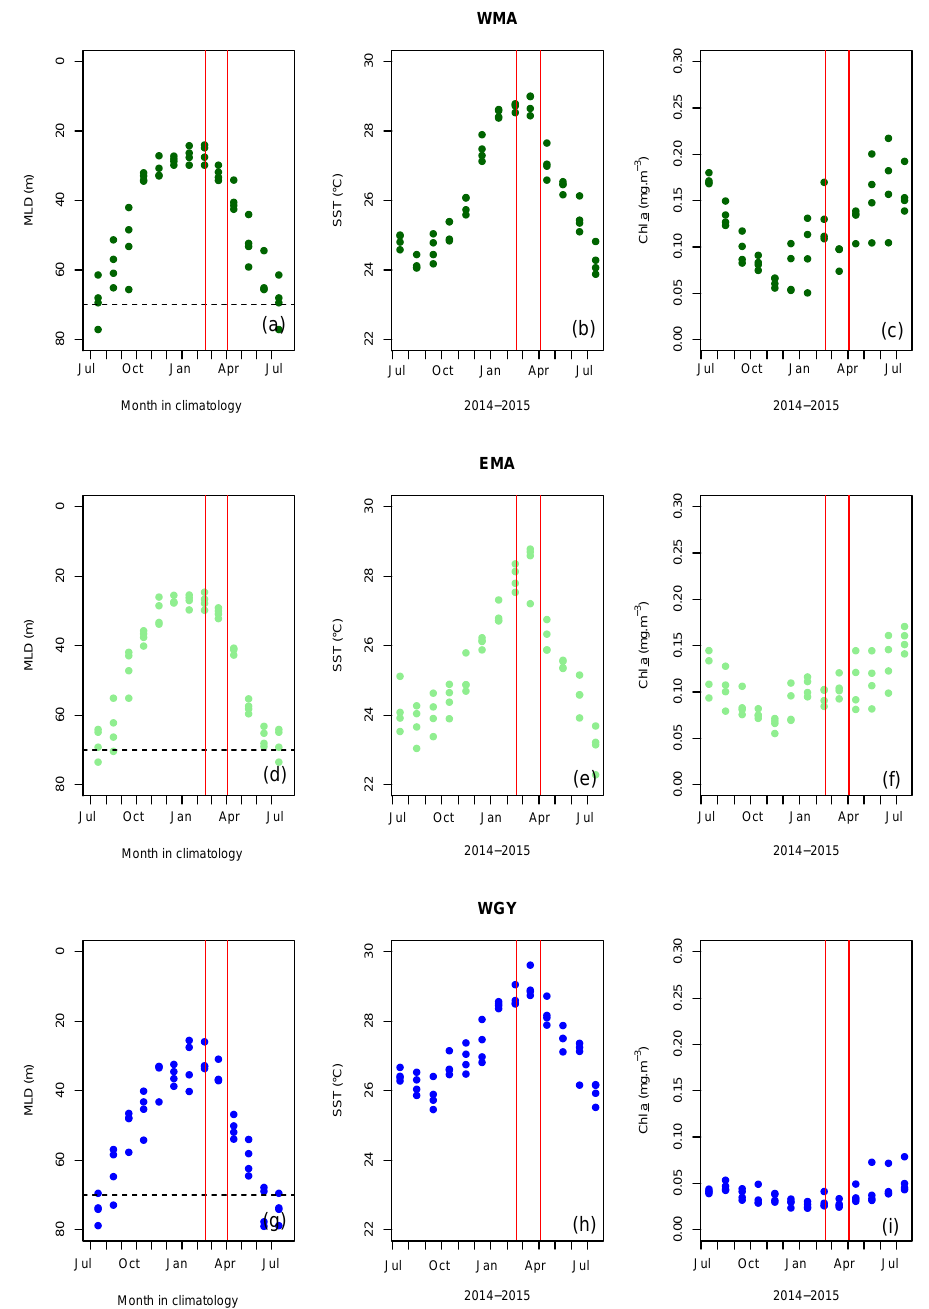
Figure 2. Monthly mean mixed layer depth (MLD) against month in climatology (a, d, g) , sea surface temperature (SST) (b, e, h) , and Chl a (c, f, i) against months from July 2014 to July 2015, respectively, for (a, b, c) the western Melanesian Archipelago (WMA), (d, e, f) the eastern Melanesian Archipelago (EMA) and (g, h, i) the western SP gyre (WGY). The horizontal dashed lines indicate the mixed layer depth of 70m. The vertical red lines indicate the period of the OUTPACE cruise: 18 February to 3 April